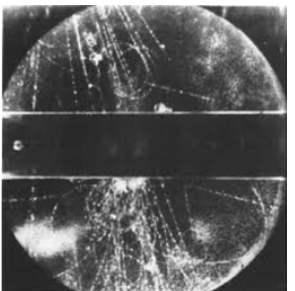
Figure 2. One of the “V” particles discovered by Rochester and Butler in 1947 [1]. The inverted V, visible to the right just below the plate across the chamber, is formed by the tracks of the decay products of a neutral